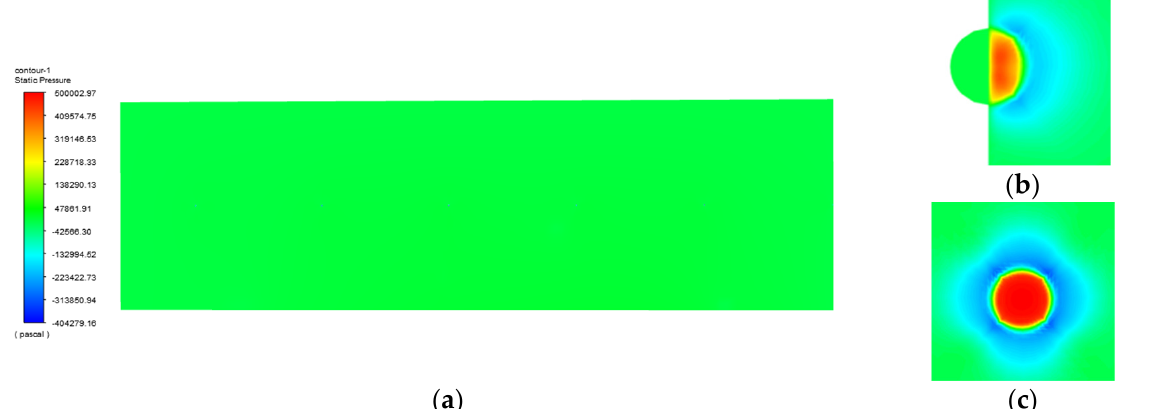
Figure 8. ( a ) Pressure distribution on an unbalanced surface of an air film (0.5 MPa). ( b ) Pressure distribution near the half-covered throttle hole. ( c ) Pressure distribution near the fully covered throttle hole.